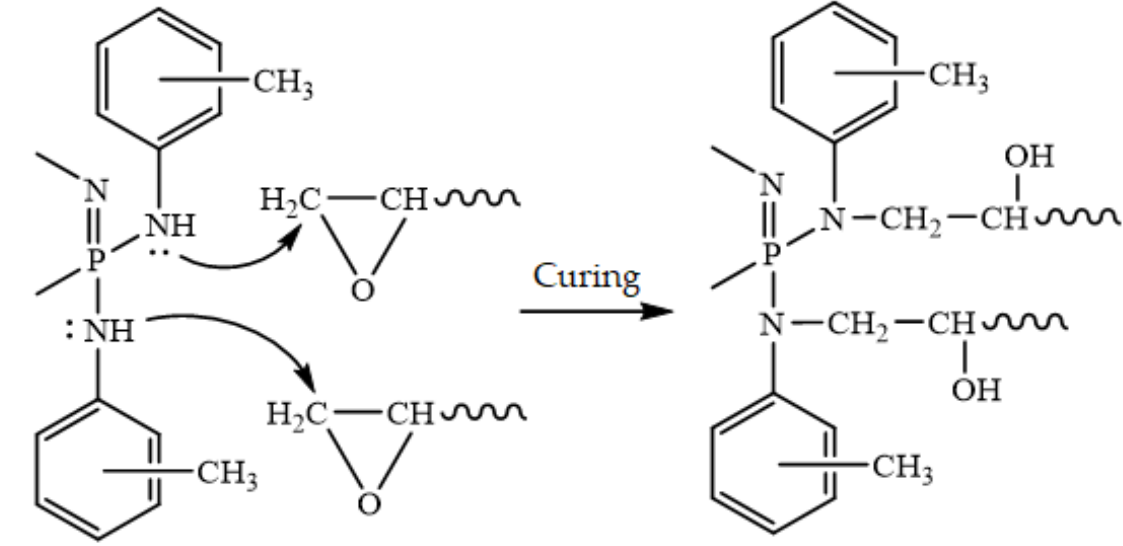
Figure 7. Diagram of the probable interaction of oxirane groups with AAP in the hardening of epoxy